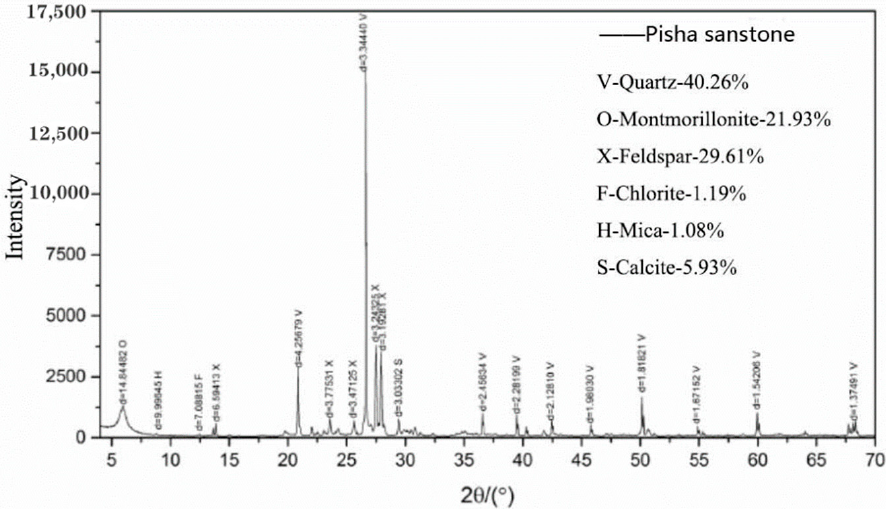
Figure 1. Mineral composition of the Pisha sandstone sample.